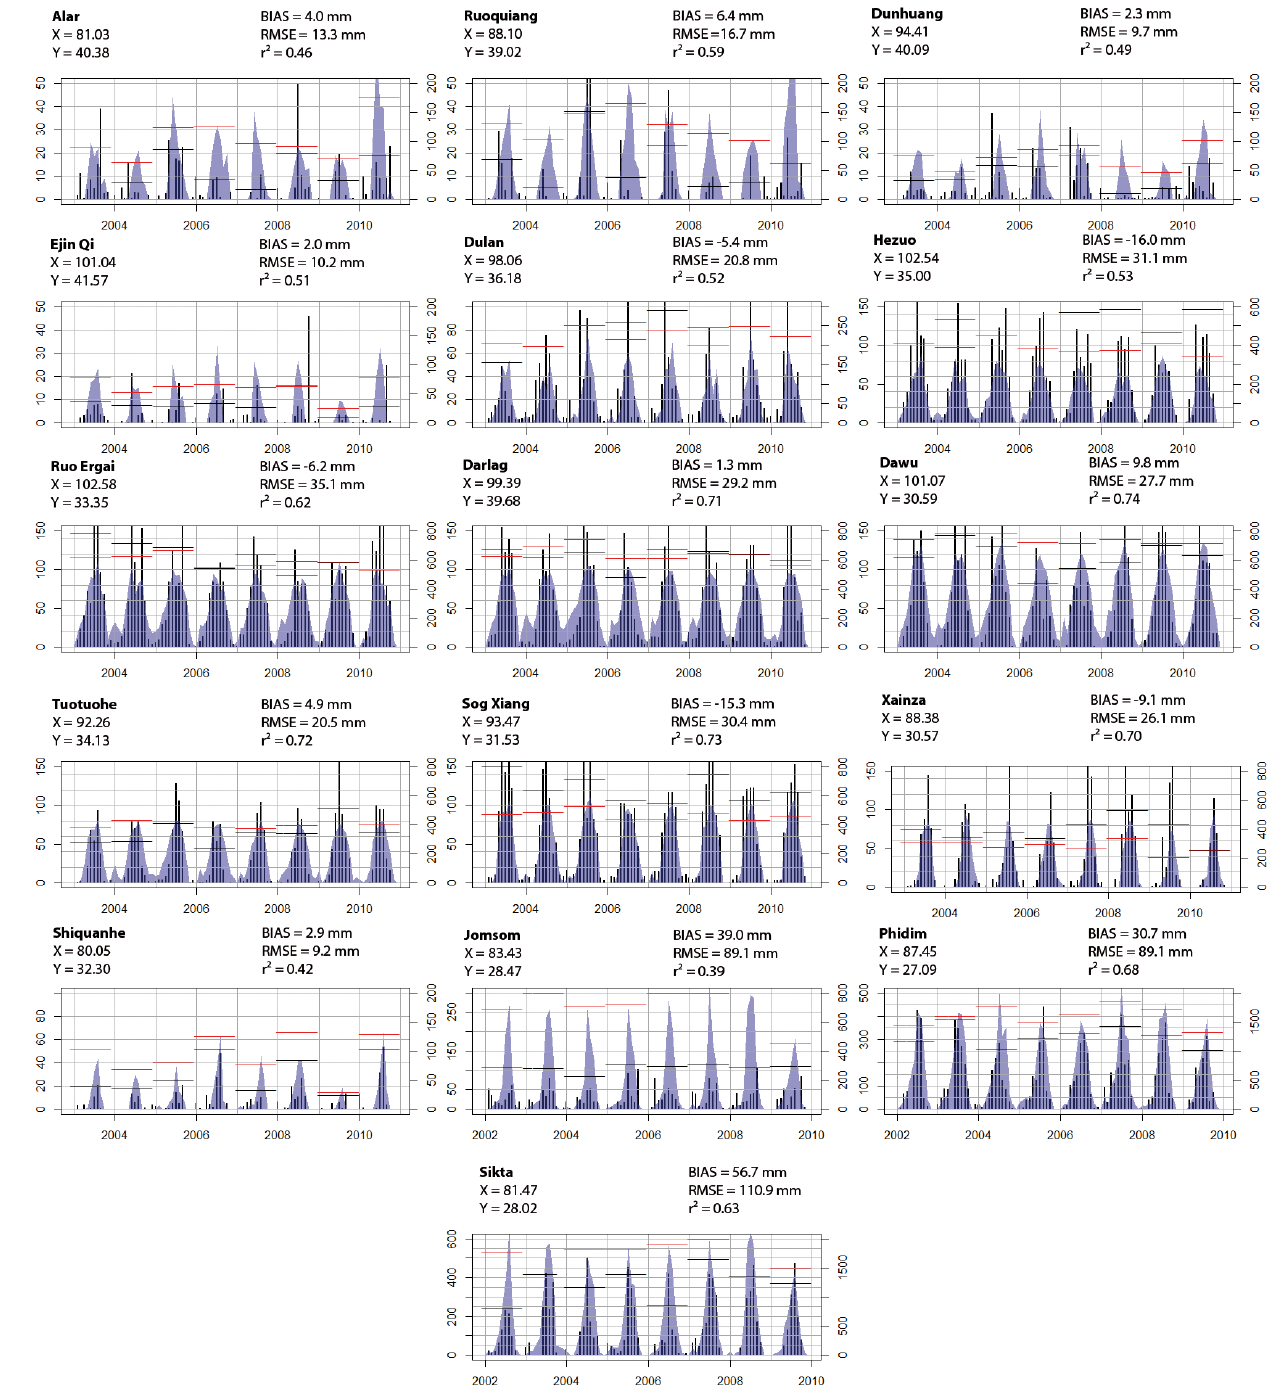
Figure 6. Observed (black bars) and modeled (polygons) monthly precipitation sums [mmmonth − 1 ] (left y axis) and observed (black lines) and modeled (red lines) annual precipitation sums [mma − 1 ] (right y axis) for 16 stations of the evaluation data set. The scale of the y axis is adapted to the maximum precipitation amount at each